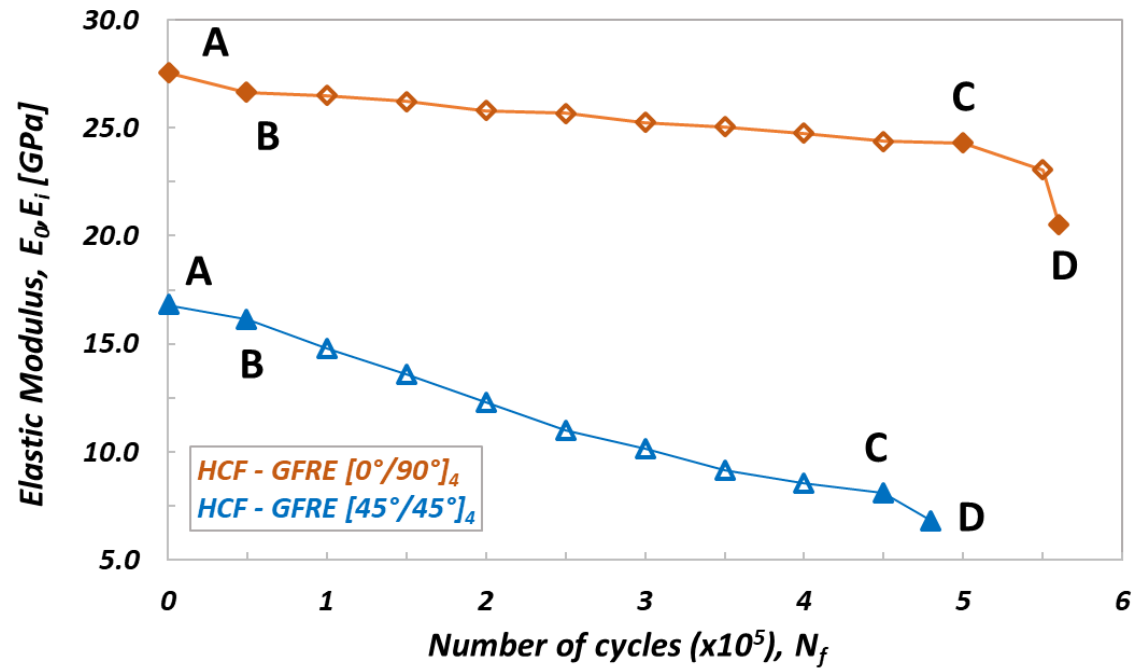
Figure 6. Variation of the elastic modulus versus number of cycle for specimens of different fibers orientation obtained for HCF tests. AB — crack initiation (crack in the transverse yarn), BC — crack growth (interlaminar debonding), CD — ultimate failure (fibers breakage).